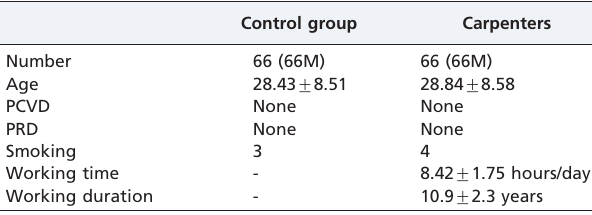
Table 1 - Characteristic of control group and carpenters.